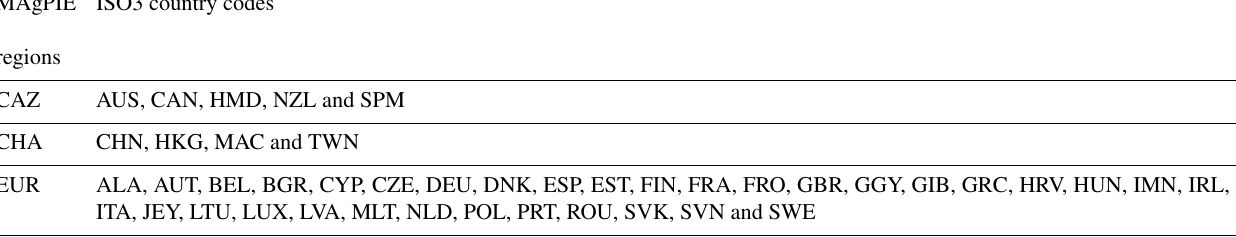
Table A1. ISO3 codes of countries belonging to standard MAgPIE regions. MAgPIE ISO3 country codes regions